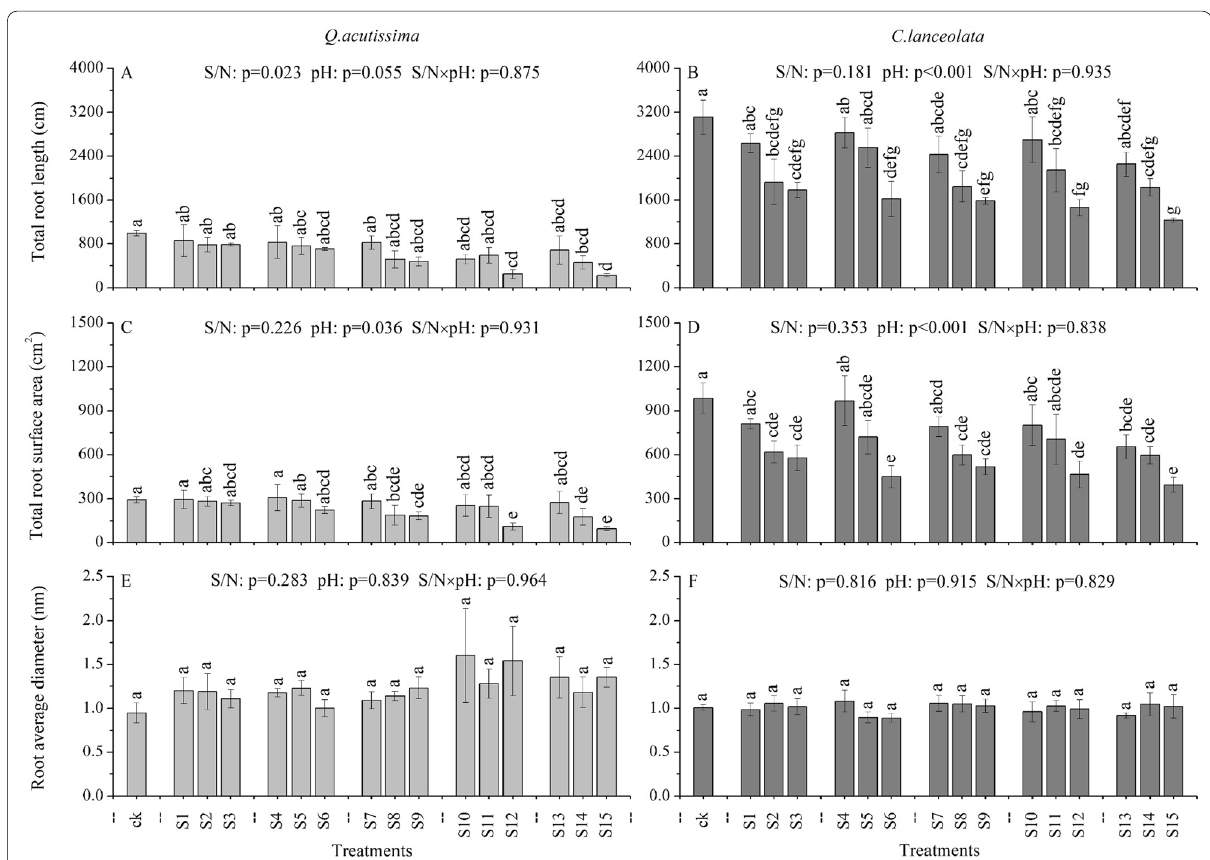
Fig. 2 Variations in the root morphologies between treatments. The analysis and meaning of the letters are consistent with Fig.